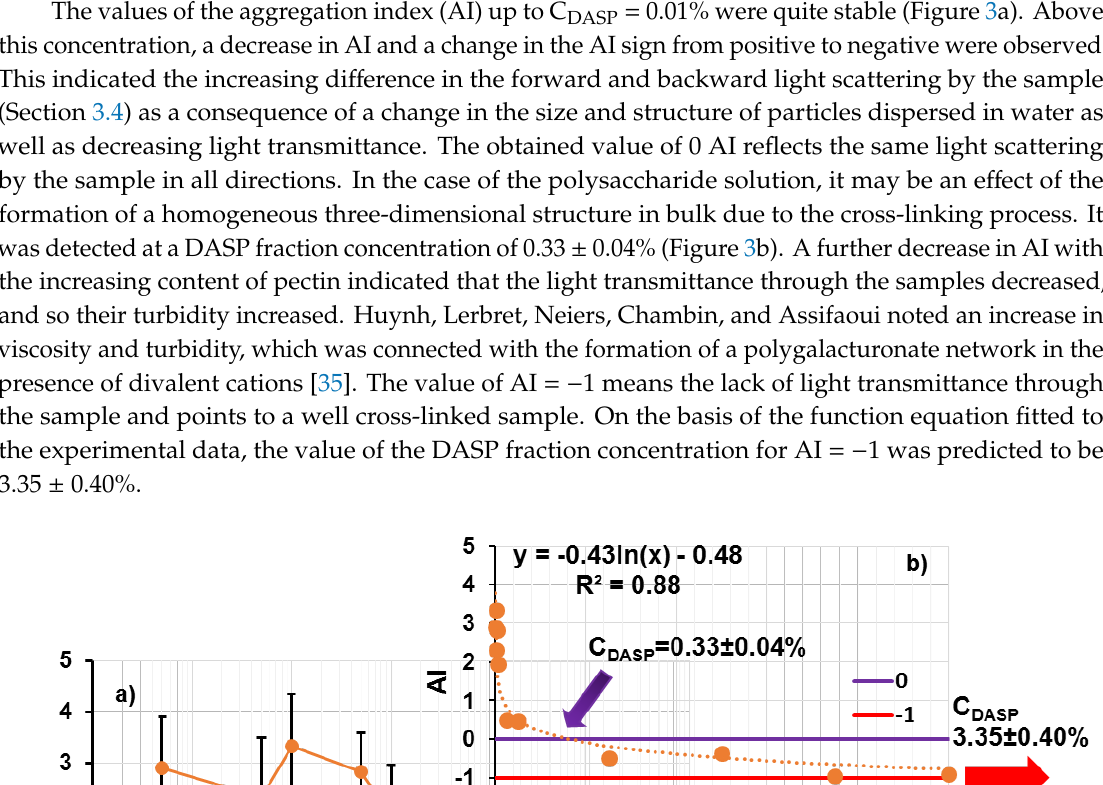
Figure 2. Relationship between the relative mean hydrodynamic diameter (relative Z ave ) and the DASP fraction concentration (C DASP ); the bars indicate standard deviation.